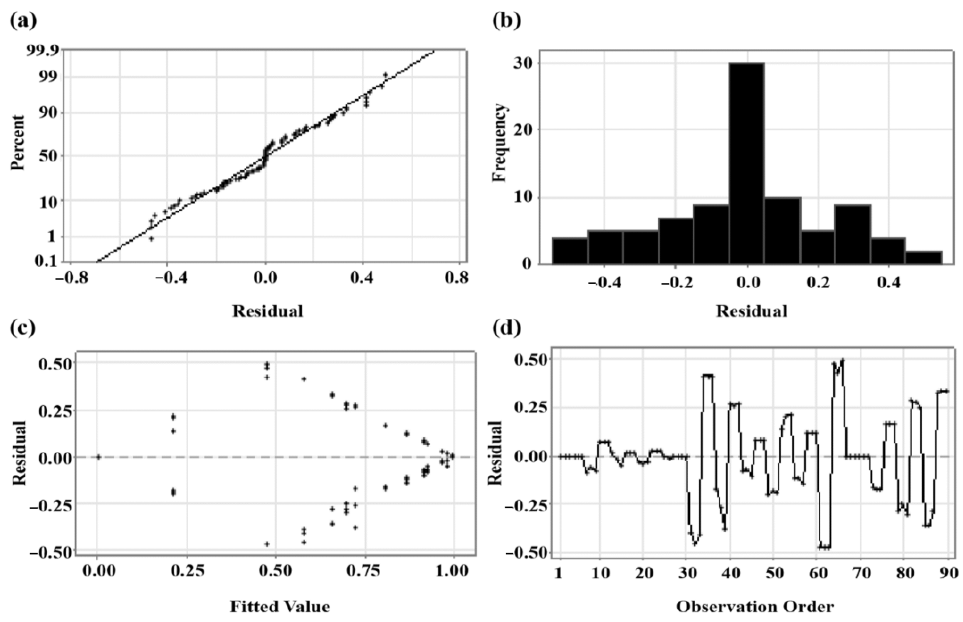
Figure 13. ( a ) Normal probability plot, ( b ) histogram, ( c ) versus fits, and ( d ) versus